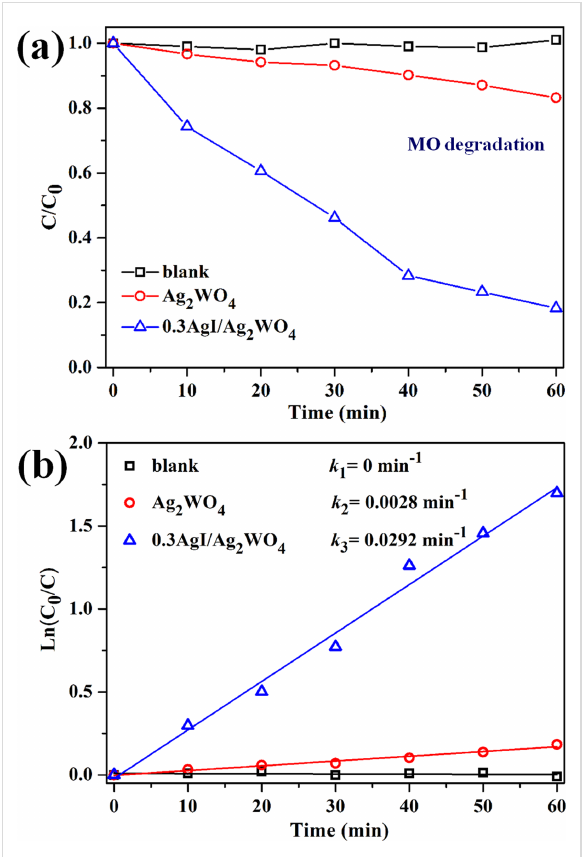
Figure 6: (a) The photocatalytic degradation and (b) degradation rate constants of MO (100 mL, 5 mg L − 1 ) using the catalysts (10 mg).